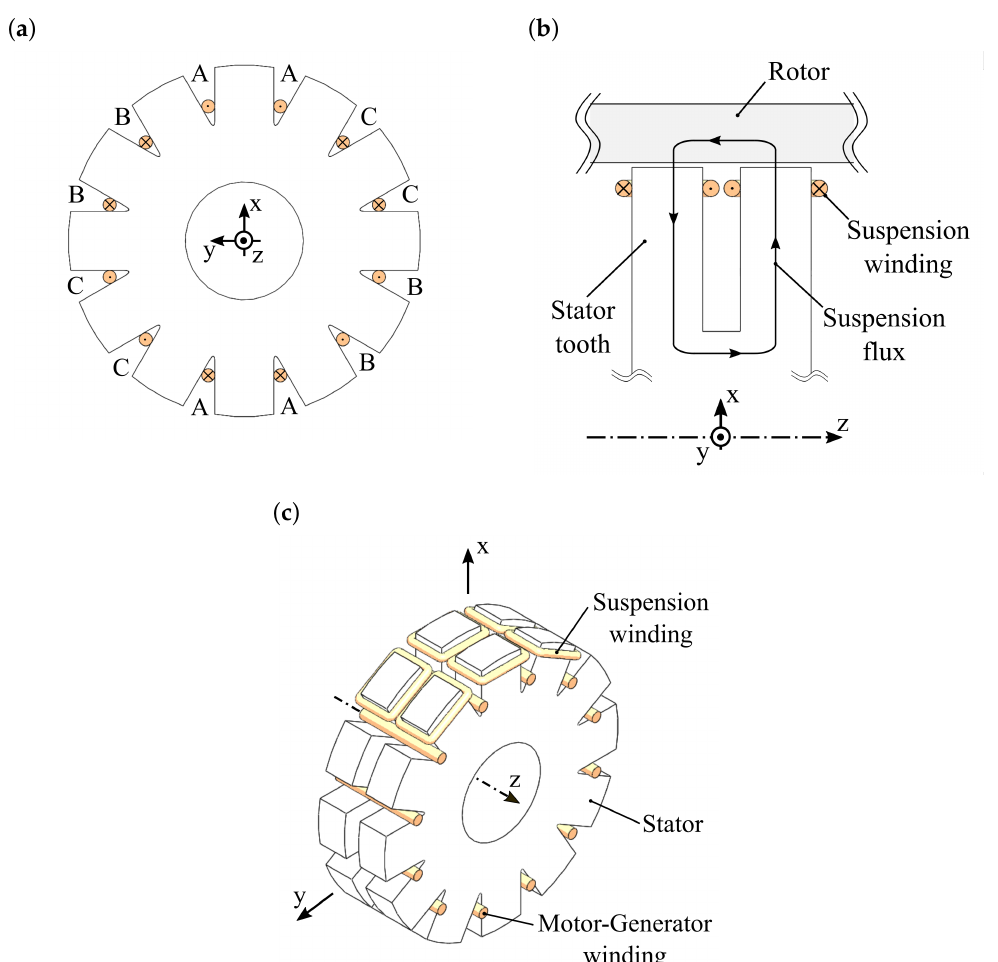
Figure 2. Schematic of the self-bearing hysteresis drive. ( a ) View in the xy -plane (the transversal plane of the flywheel) with the three-phase (A, B, C) winding scheme of the motor-generator function. ( b ) Partial cross-section in the xz -plane (the longitudinal plane of the flywheel) with the winding scheme responsible for the suspension flux generation only. ( c ) Isometric view.